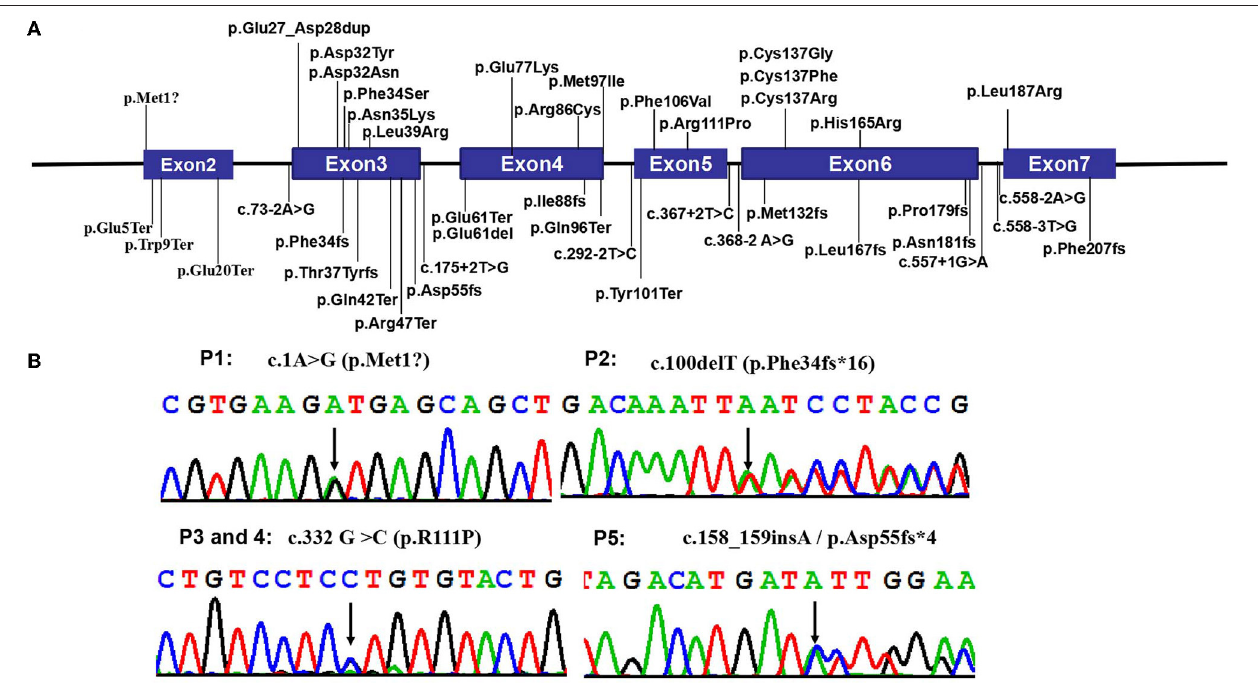
FIGURE 2 | Pathogenic CSNK2B variants. (A) The distribution of all CSNK2B variants detected so far in the 57 reported patients and 5 in this study. Boxes represent six different exons as indicated, and solid lines connecting these boxes represent the introns of CSNK2B gene. The numbers above the boxes indicate the positions of the CSNK2B complementary DNA at the start-stop sites and exon-intron boundaries. Vertical lines represent the locations of missense (above the boxes) or deletion/nonsense/frameshift/splicing (below the boxes) variants. (B) The Sanger chromatograms of the detected variants in patients 1–5. Among them, P1